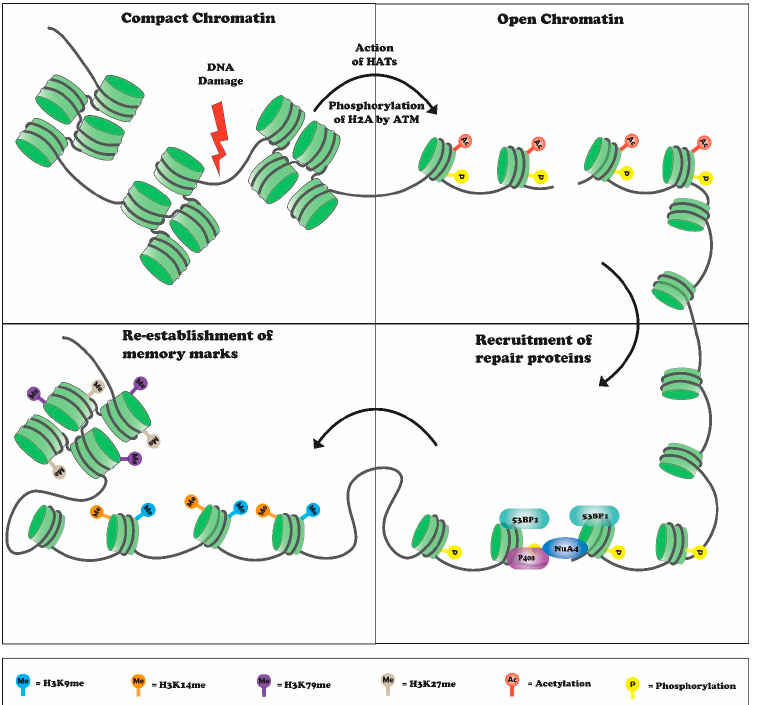
Figure 1. DNA damage initiates chromatin decompaction mediated by various histone acetyltransferases (HATs) and recruits various DSB-repair and chromatin-modifying proteins. Binding of these proteins, such as 53BP1, NuA4, and P400, leads to DSB repair followed by chromatin compaction, which helps in maintaining genome integrity.